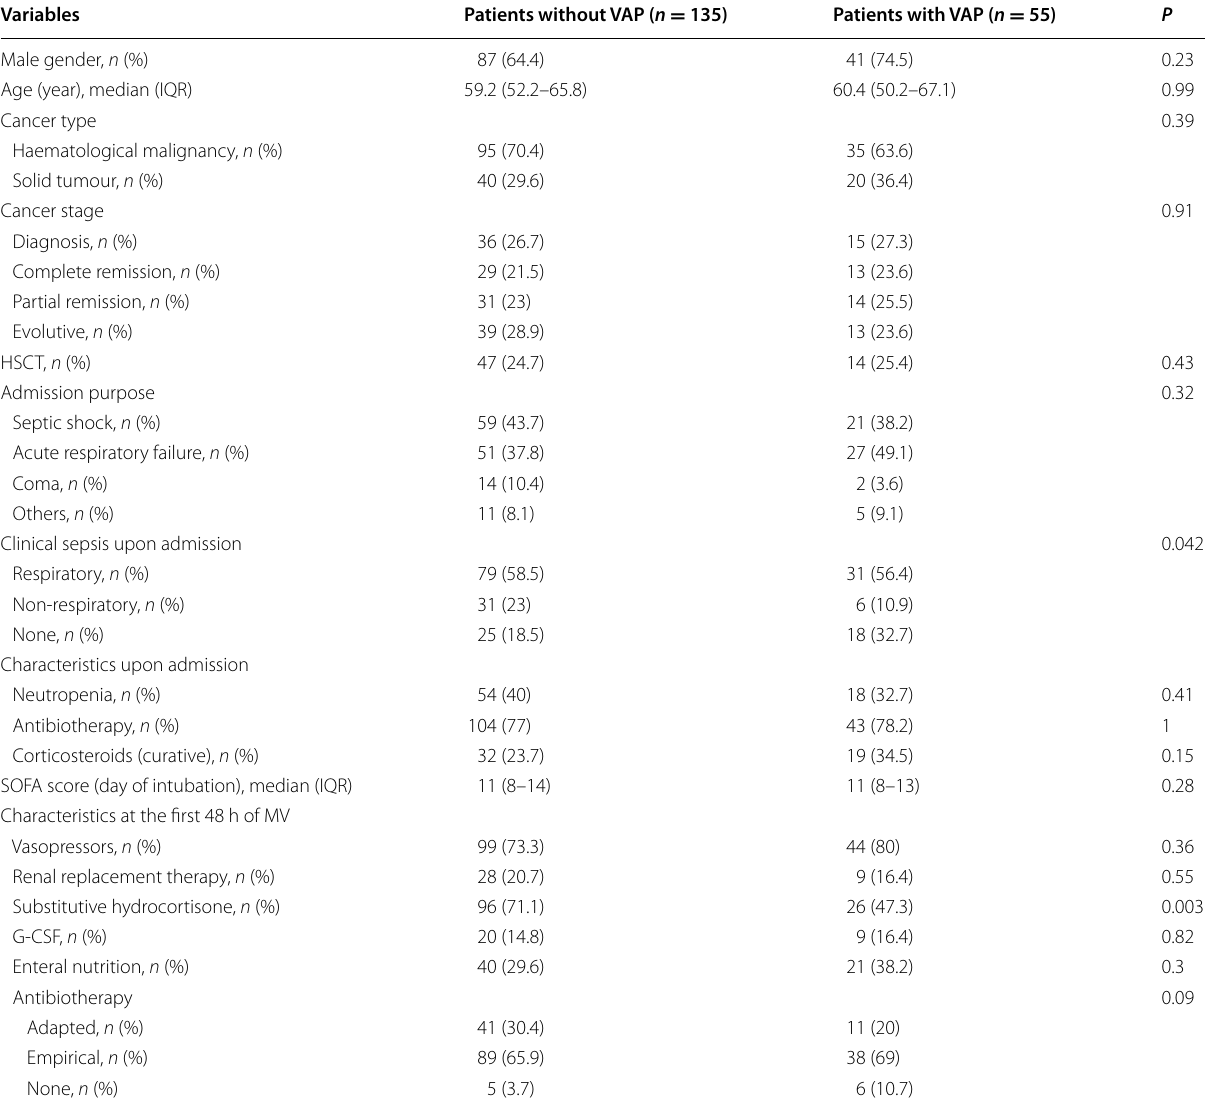
Table 2 Patient’s